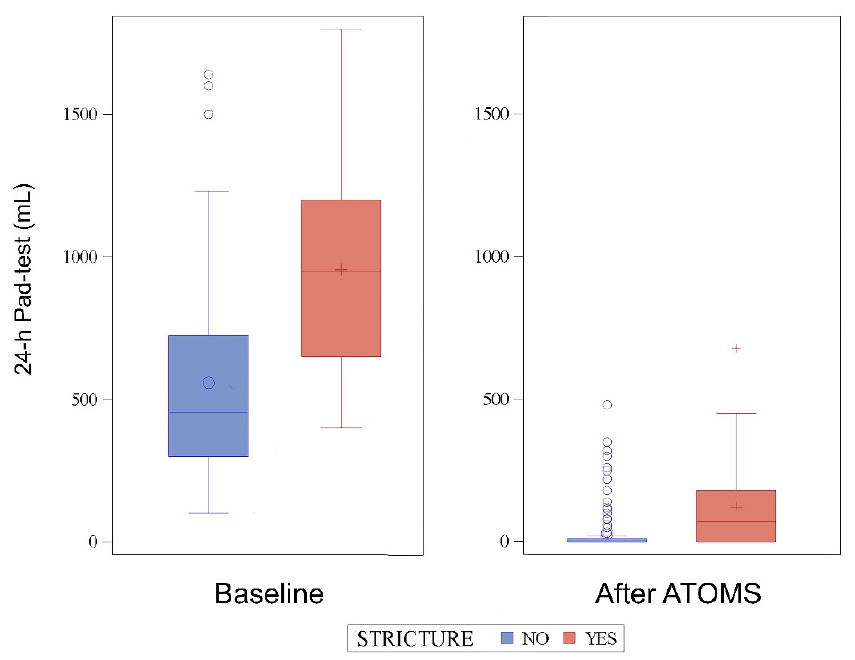
Figure 1. The 24-h pad test evolution before and after the ATOMS implant.